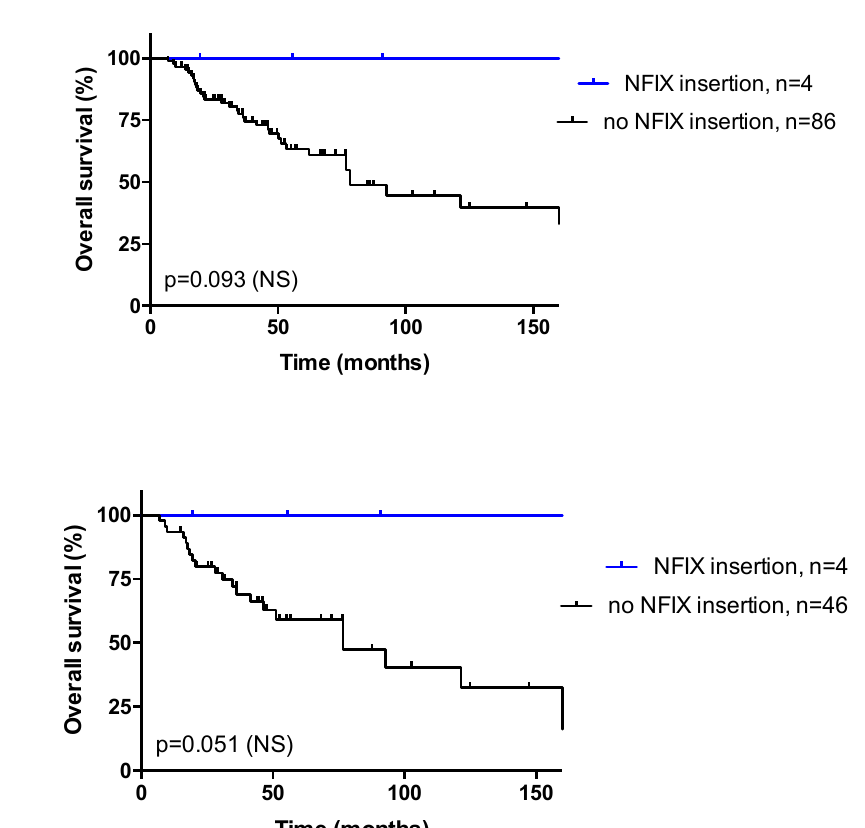
Figure 4. Overall survival (OS) curves in patients with anal squamous cell carcinoma (ASCC) and HPV insertion into NFIX gene; ( a ) in the overall cohort ( n = 90 evaluable patients). Median OS: not reached in patients with NFIX insertion vs. 78.3 months in patients without NFIX insertion. Log-Rank test, p = 0.093. ( b ) in the subgroup of patients with HPV integration ( n = 50 evaluable patients). Median OS: not reached in patients with NFIX insertion vs. 76.7 months in patients without NFIX insertion. Log-Rank test, p = 0.051. NS: not significant.